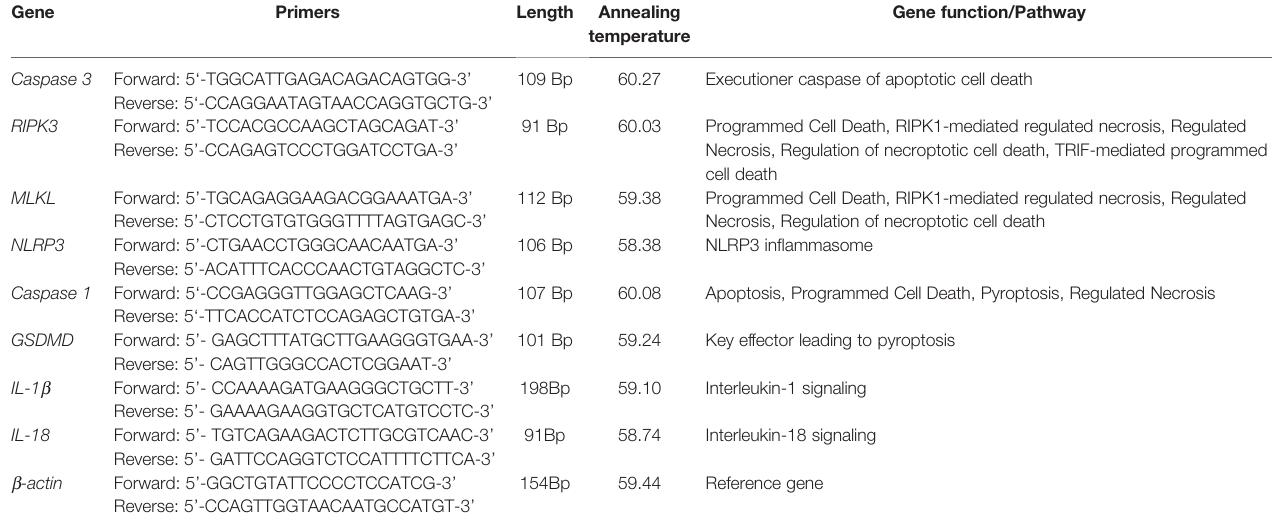
TABLE 1 | Table of primer sequences for RT-qPCR. Gene Primers Length Annealing